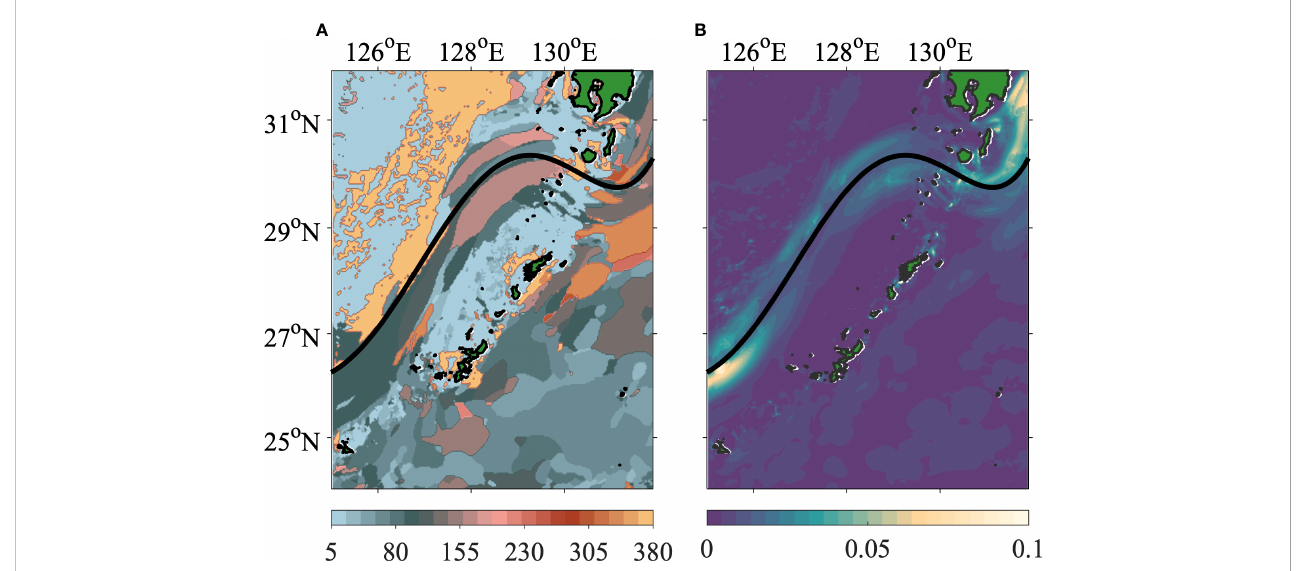
FIGURE 7 (A) Periods (unit: day) of the strongest frequency spectral amplitudes above the 95% signi fi cance level. (B) The corresponding strongest frequency spectral amplitudes (unit: m 2 /s 2 ) above the 95% signi fi cance level. The spectra were calculated for the current velocity fi eld during 2003 – 2012 and vertically averaged. Black thick lines represented the mean Kuroshio axis during 2003 –